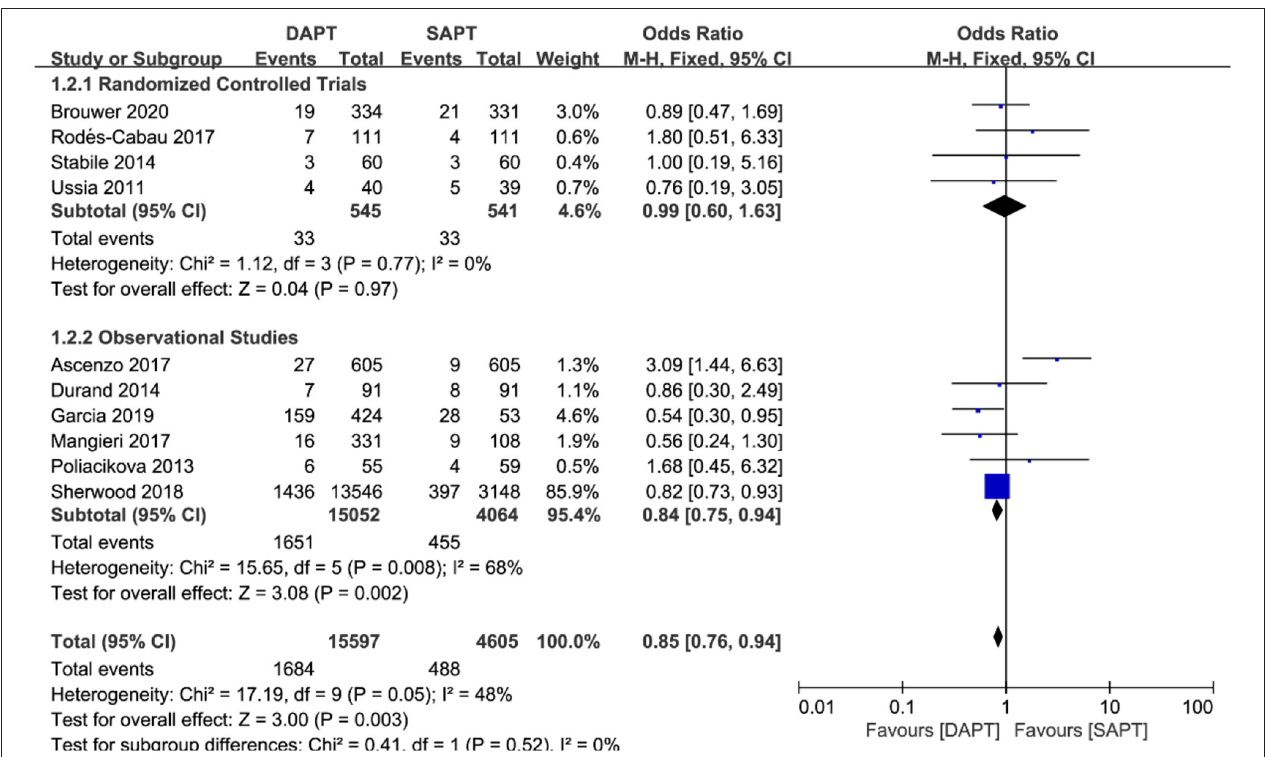
FIGURE 4 | Forest plot for all-cause mortality with subgroup analysis stratified by study type at longest follow-up.